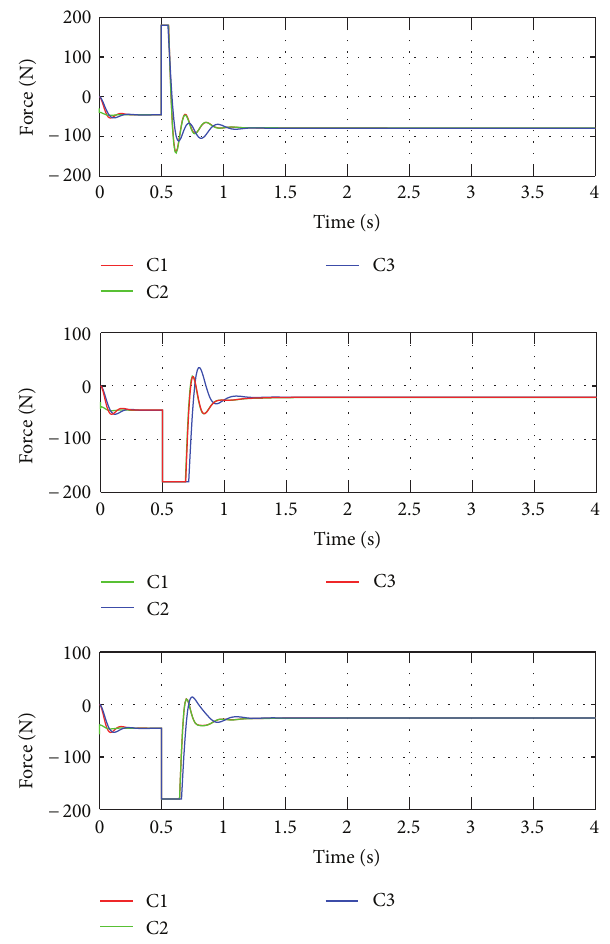
Figure 9: Response to step input: control efforts.